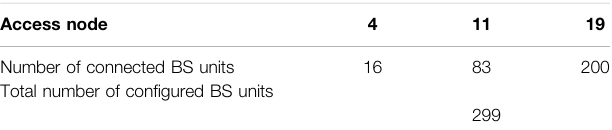
TABLE 1 | Optimal con fi guration results of battery storage (BS) in the isolated micro-grid considering DR. Access node